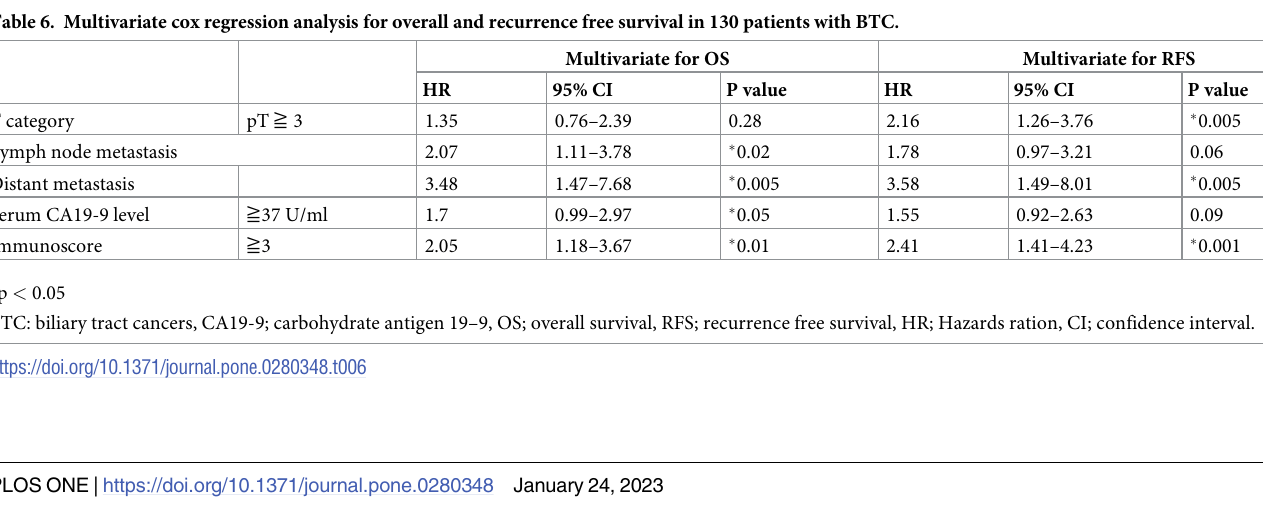
Table 6. Multivariate cox regression analysis for overall and recurrence free survival in 130 patients with BTC.